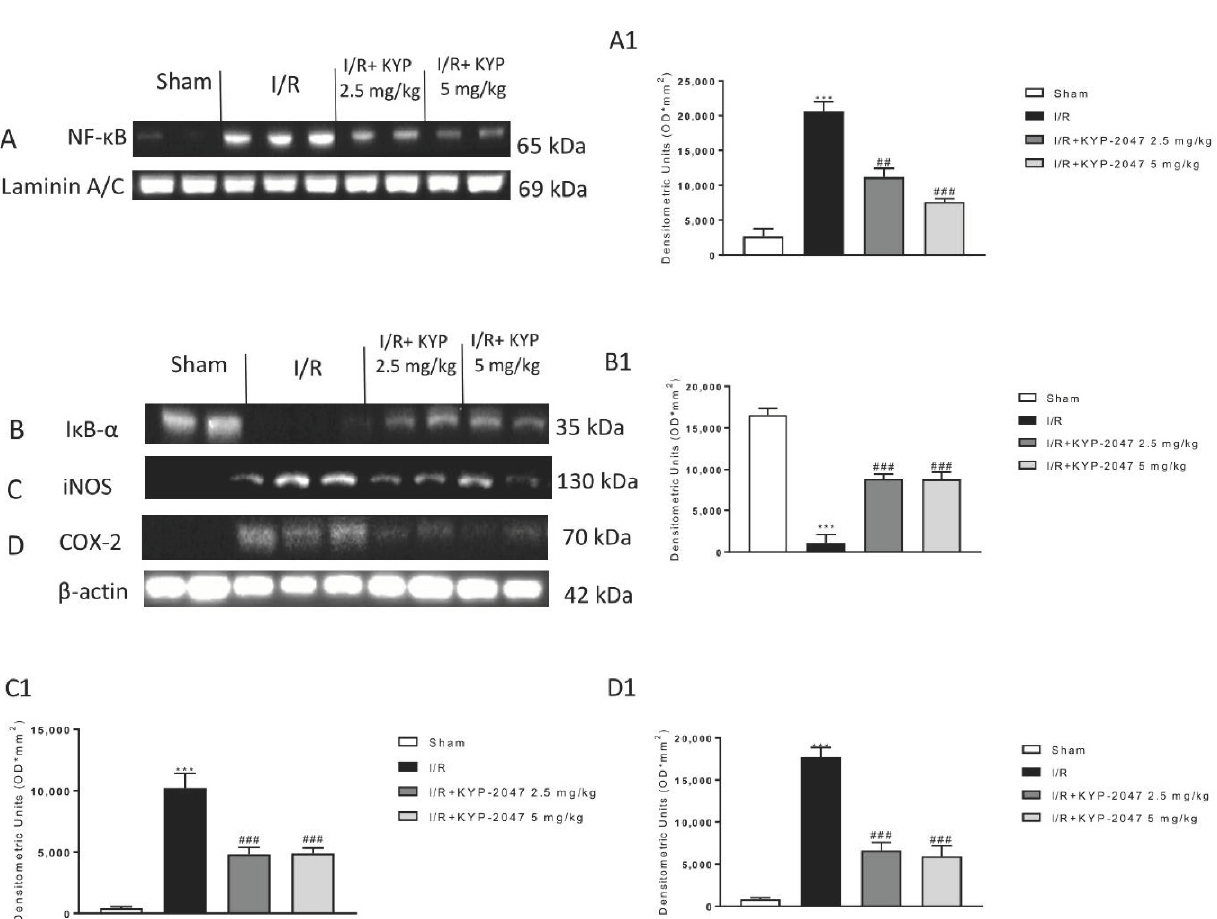
Figure 2. Effects of KYP-2047 on NF- ĸ B pathway and pro-inflammatory enzymes iNOS and COX-2. ( A ) Western blot analysis revealed that in the IRI group there was a significant increase of NF- ĸ B levels compared to the sham group and a significant decrease in I ĸ B- α expression levels. ( A1 ) Densitometric analysis referred to blot in panel A. ( B ) KYP-2047 2.5 mg/kg and 5 mg/kg treated groups showed a significant decrease of NF- ĸ B nuclear translocation and a significant increase of I ĸ B- α levels. ( B1 ) Densitometric analysis referred to blot in panel B. ( C , D ) Expression levels of pro-inflammatory iNOS and COX-2 enzymes were increased in IRI group compared to the sham group, while a significant decrease was observed in the KYP-2047 2.5 mg/kg and 5 mg/kg treated groups. ( C1 , D1 ) Densitometric analysis referred to blots in panels C and D. Data is expressed as mean ± S.E.M. Data are representative of at least three independent experiments. *** p < 0.001 vs. Sham; ## p < 0.01 vs. IRI; ### p < 0.001 vs. IRI.